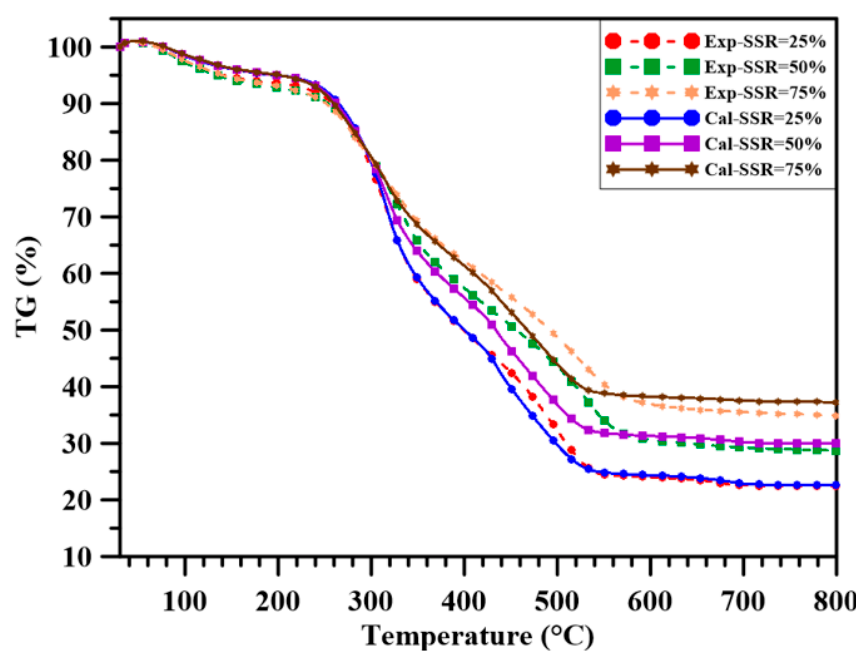
Figure 7. Synergistic effect for various sludge-shiitake ratios.